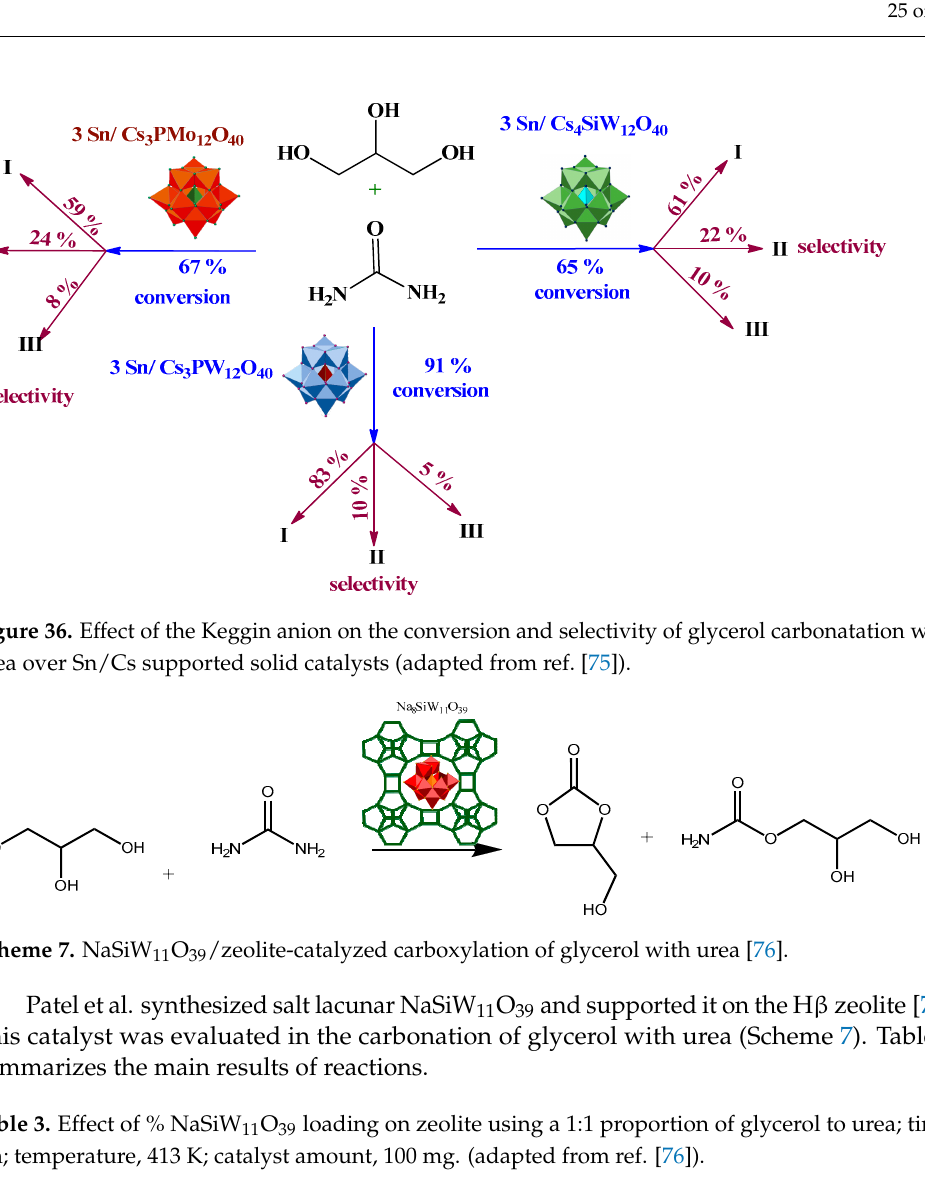
Table 3. Effect of % NaSiW 11 O 39 loading on zeolite using a 1:1 proportion of glycerol to urea; time, 8 h; temperature, 413 K; catalyst amount, 100 mg. (adapted from ref. [76]). Loading/%